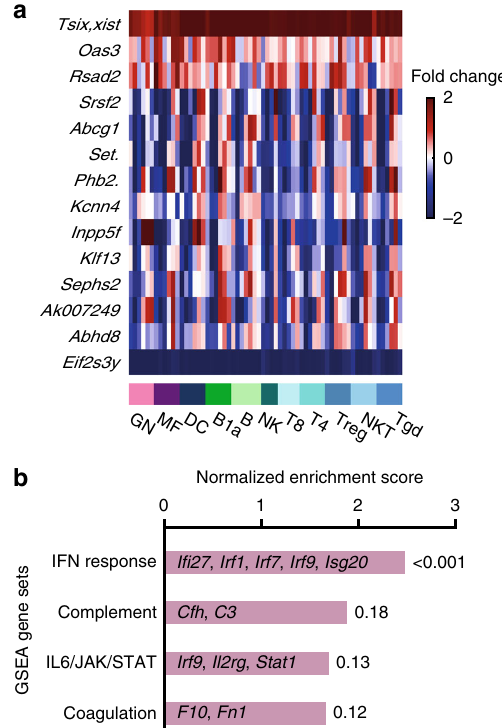
Fig. 2 Pan-immune transcriptional sexual dimorphism. a Heatmap of log 2 fold change (female – male expression) of pan-immune female and male sexually differentially expressed genes (SDEGs) (datasets A and B, paired t test pFDR < 0.2, female – male fold change >1.5). For genes with multiple names, only the fi rst is shown and then period. Source data included in Supplementary Table 2. b Female enriched pathways identi fi ed by pre- ranked gene set enrichment analysis [GSEAPreranked 34 (FDR < 25%) of the t statistic, sorted by normalized enrichment scores]. FDR corrected p value is displayed to the right of each bar. Source data included